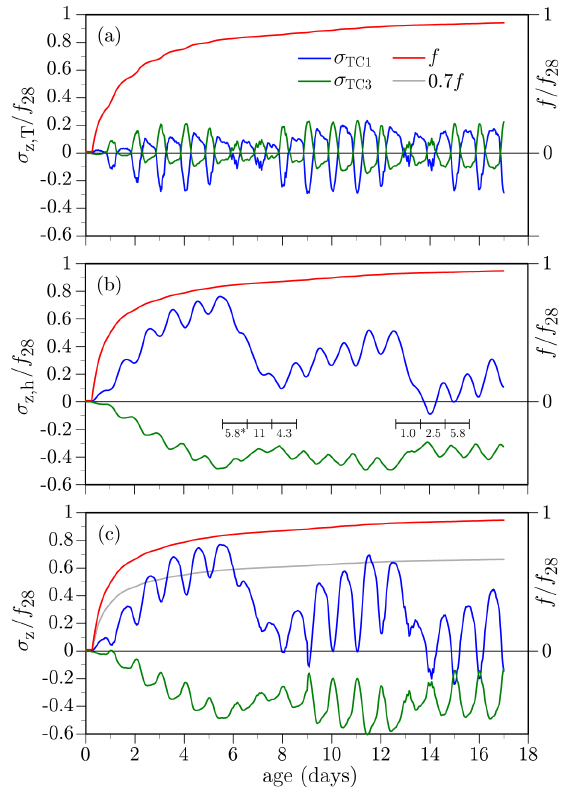
Figure 20. Simulated stresses at mid-deck location when the curing media is absent: ( a ) hygral stress component (* daily rainfall, in mm, recorded at the Carmichael 0.9 S meteorological station); ( b ) thermal stress component; and ( c ) total